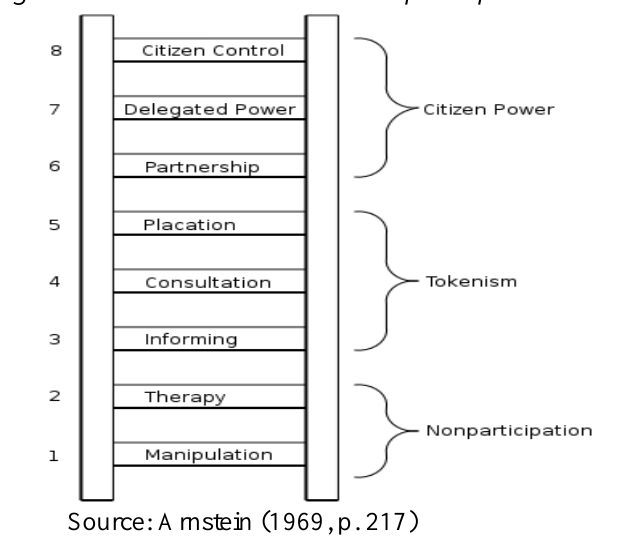
Figure 2: Arnstein’s ladder of citizen participation